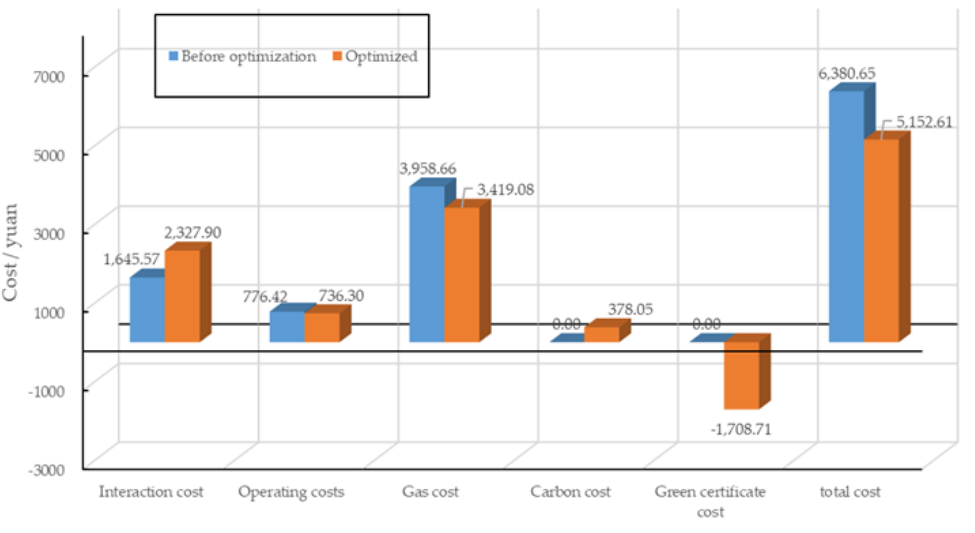
Figure 5. Cost comparison chart.